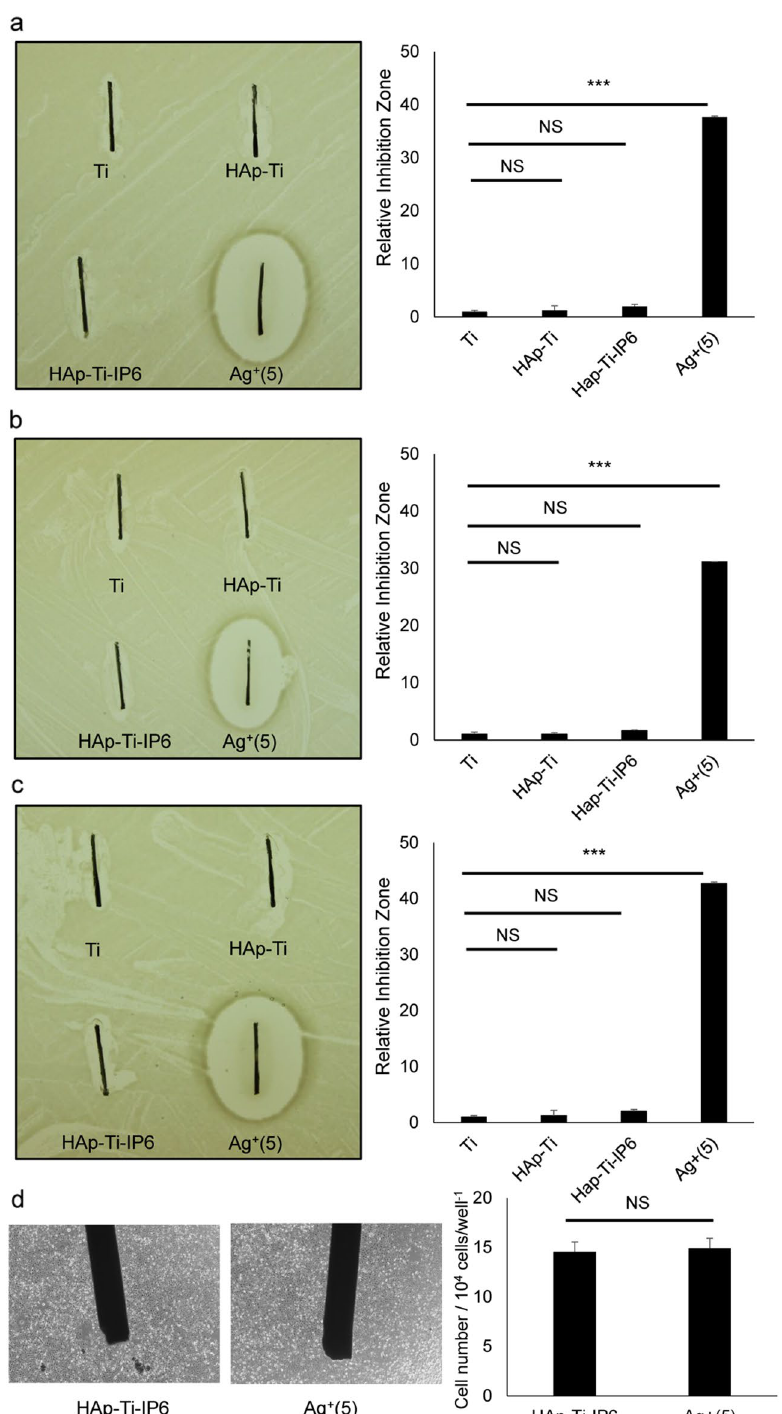
Figure 2. In vitro antibacterial effect of IP6-immobilized silver ions on a HAp rod. ( a and b ) Porphyromonas gingivalis ( P. gingivalis ) was cultured on a BHIHM agar plate, and then four different Ti pins (all 0.5 mm wide × 8 mm long)—(1) without surface modification (Ti), (2) coated with HAp alone (HAp-Ti), (3) coated with HAp-IP6 (HAp-Ti-IP6), or (4) coated with HAp-IP6-Ag + (Ag + (5)). Coating of the titanium rod surface was performed at 7 days ( a ), 8 months ( b ) or 4 years ( c ) prior to experiments. Bacterial growth inhibition is indicated by a circle around the pin. Shown is the mean inhibitory zone relative to Ti ± SD. Quantification of growth inhibition zones indicates significant bacterial growth inhibition by HAp-IP6-Ag + (5)-Ti pins relative to all controls. (n = 3, *** p < 0.001; NS, not significant; by the Mann–Whitney test). ( d ) Osteoblastic MC3T3-E1 cells were cultured with HAp-IP6-Ag + (5)-coated or uncoated Ti-HAp-IP6 implants, and after three days of culture, observed under a phase-contrast microscope. Representative data of at least two independent experiments are